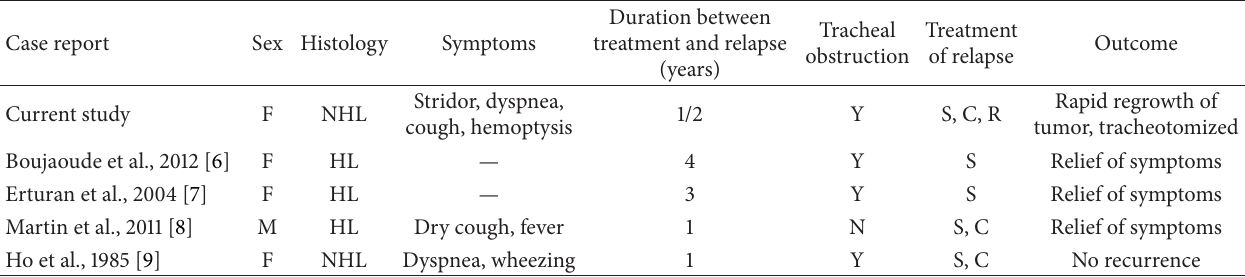
Table 1: Case reports of relapsing lymphoma involving trachea.